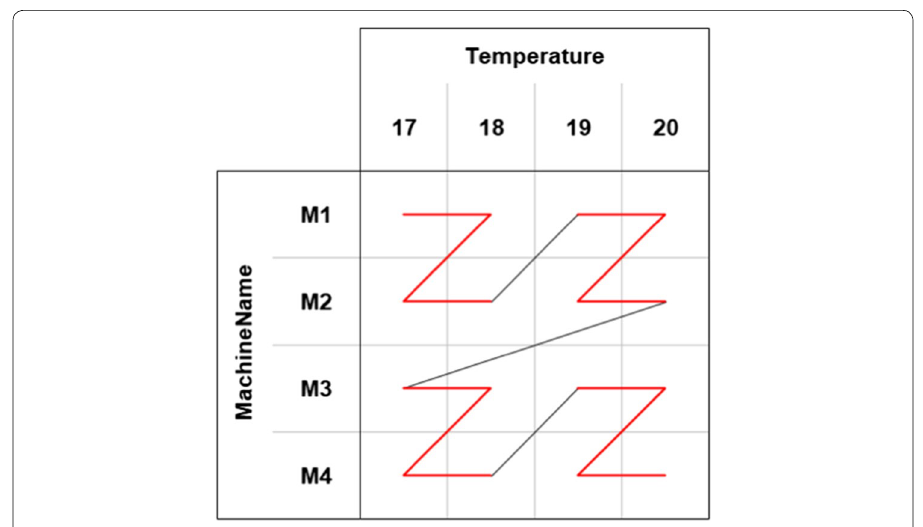
Fig. 4 Z-ordering: Example of how the data shown in Fig. 3 is rearranged based on a two-dimensional Z-ordering of the attributes Machine and